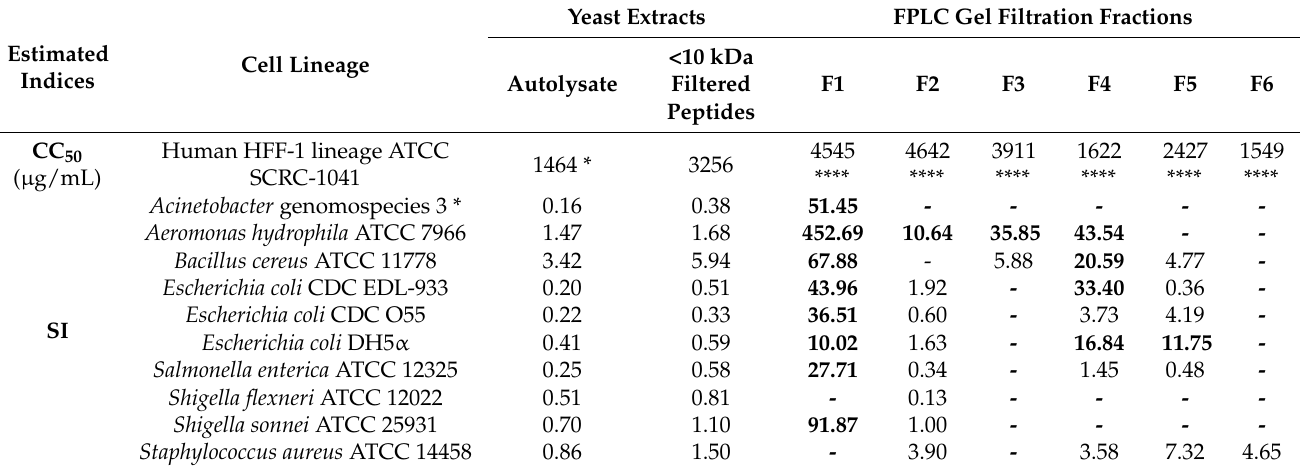
Table 2. Estimated cytotoxic concentrations (CC 50 ) and selective indices (SI) of the yeast extracts